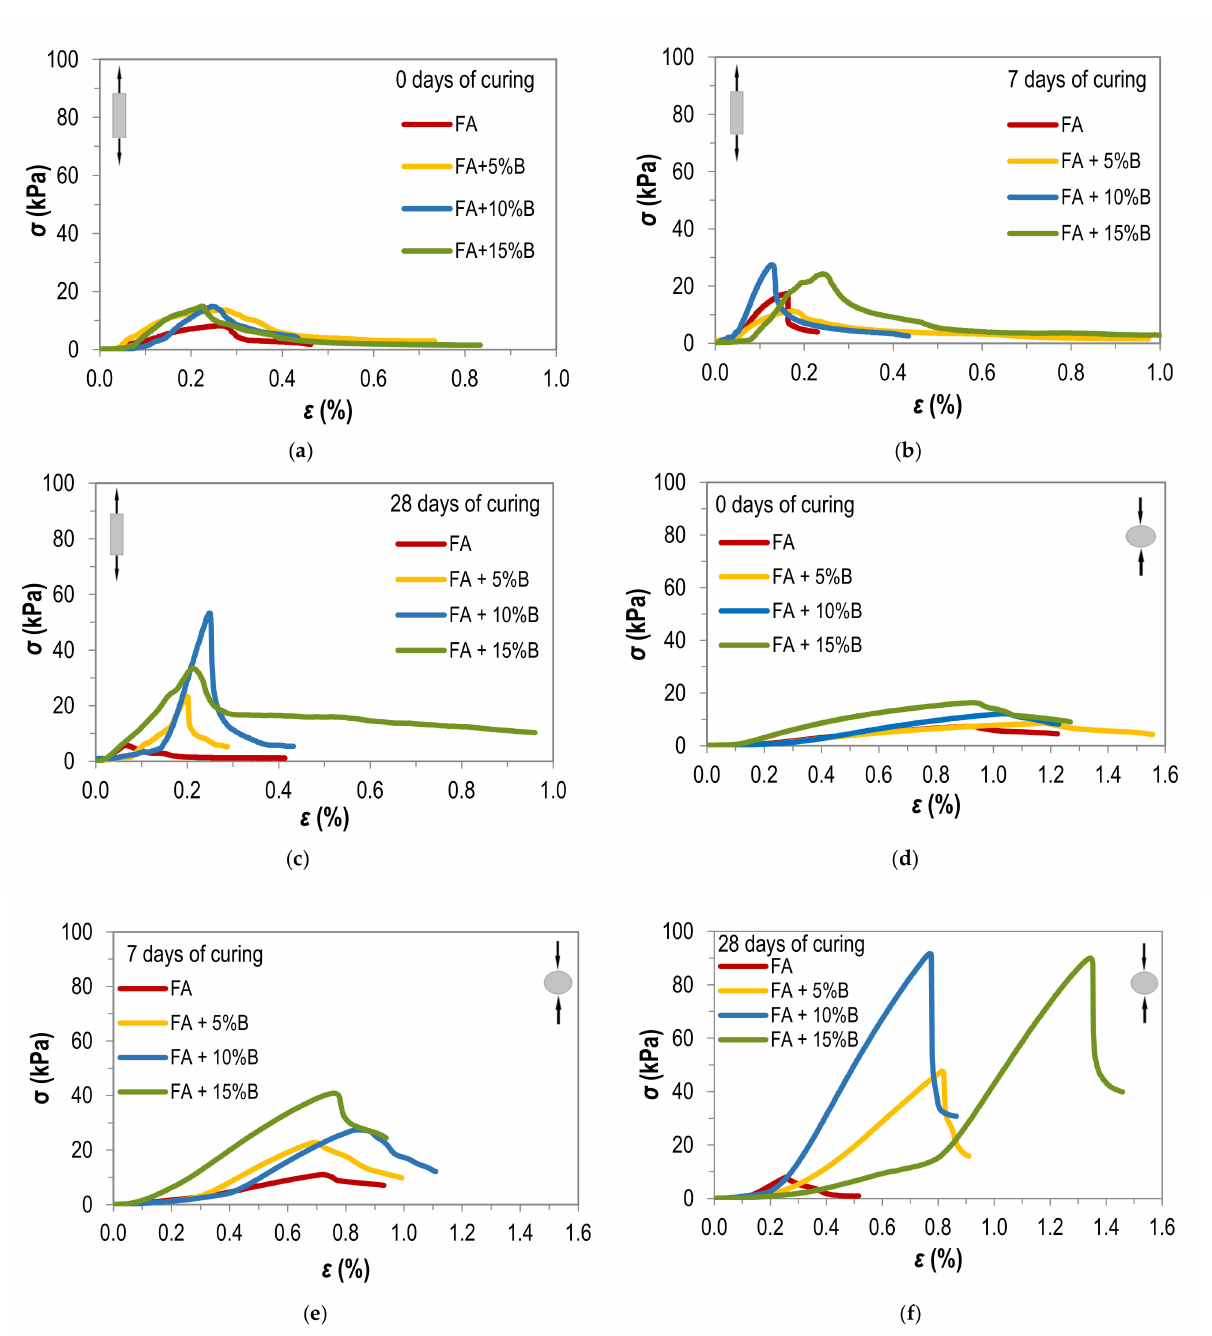
Figure 4. The results of laboratory tests of the tensile strength of the soils after different time of sample curing for: ( a – c ) direct test; ( d – f ) indirect test. Samples tested by the indirect method do not reveal the elongation from which strain